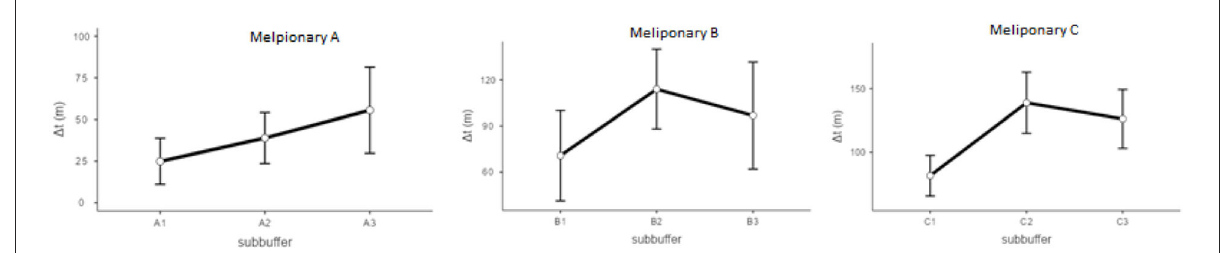
FIGURE5 Plot results for the generalized linear models regarding differences between subbuffers.